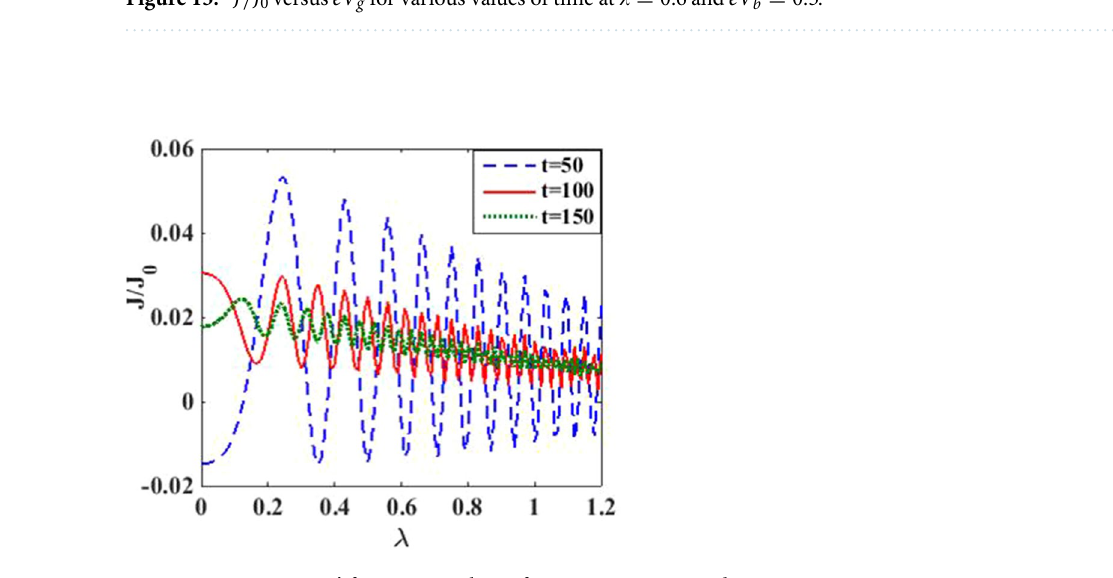
Figure 14. J / J 0 versus (cid:31) for various values of t at eV g = 0.3 and eV b = 0.5